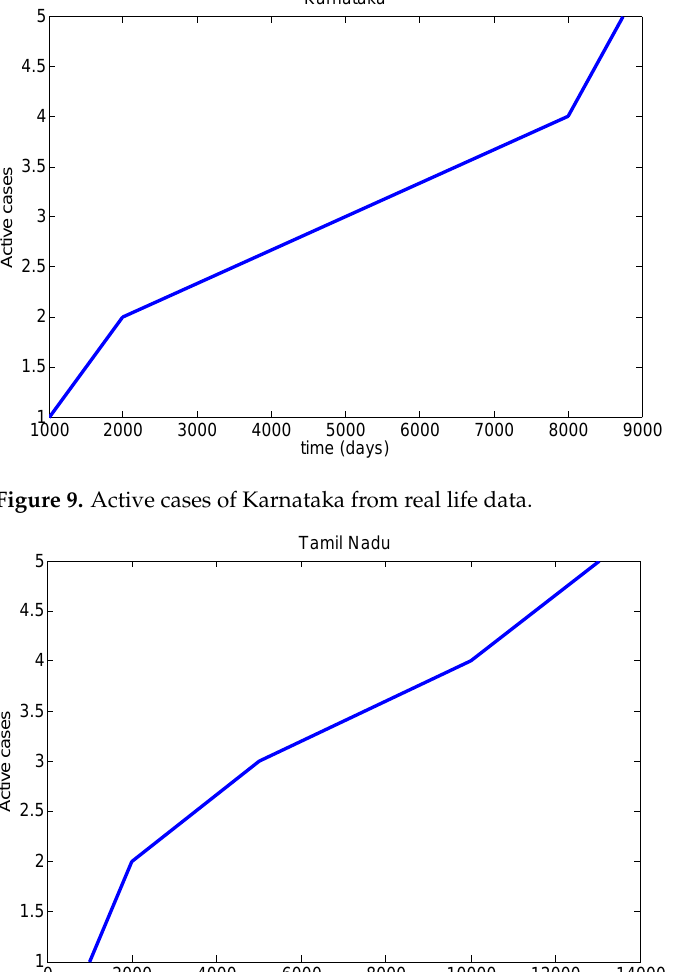
Fig. 8 Active cases of Kerala from real life data